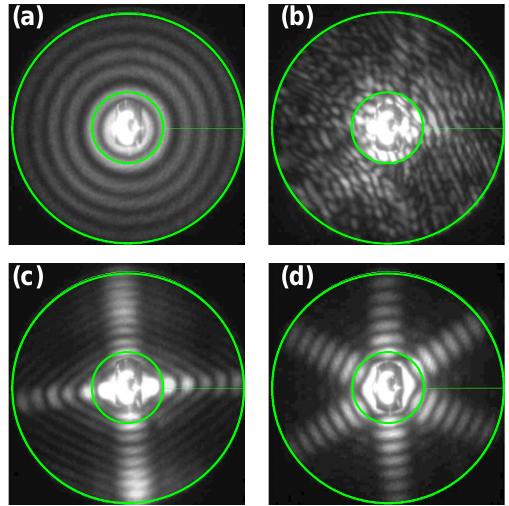
Figure 1. PPD-2K high-resolution scattering patterns of a droplet (a) , an irregular ice particle (b) , a columnar ice particle (c) , and a hexagonal ice particle (d) . A gamma correction is applied to the images for visibility.